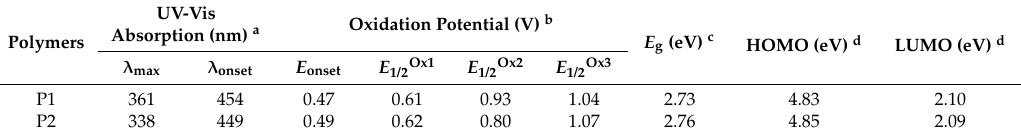
Table 1. Optical and electrochemical properties of the electrochemically synthesized polymers.